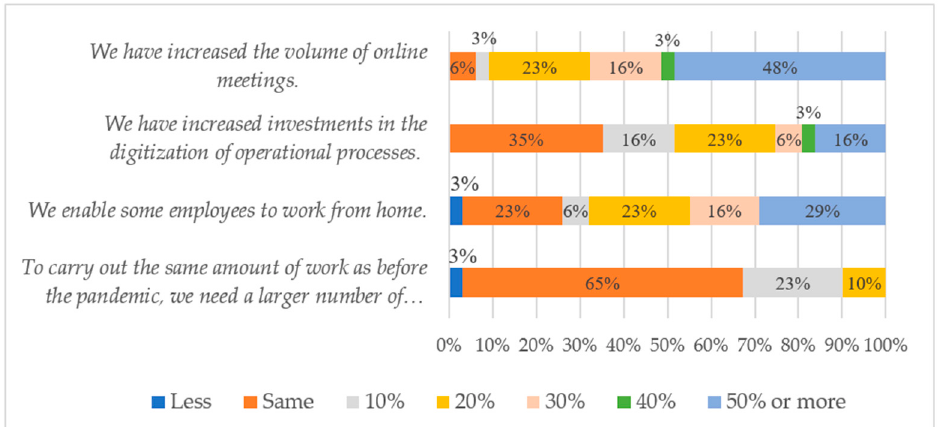
Figure 3. Changes in work and operational processes.